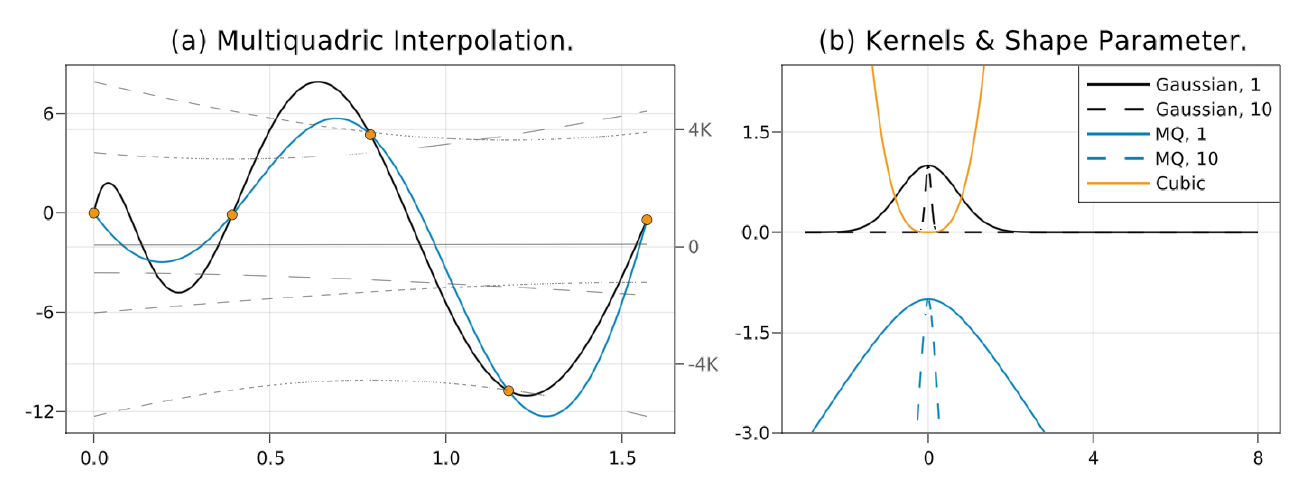
Figure 1. ( a ) Interpolation of a nonlinear function (black) by a Multiquadric surrogate (blue) based on 5 discrete training points (orange). Dashed lines show the kernels and the polynomial tail. ( b ) Different kernels in 1D with varying shape parameter (1 or 10), see also Table